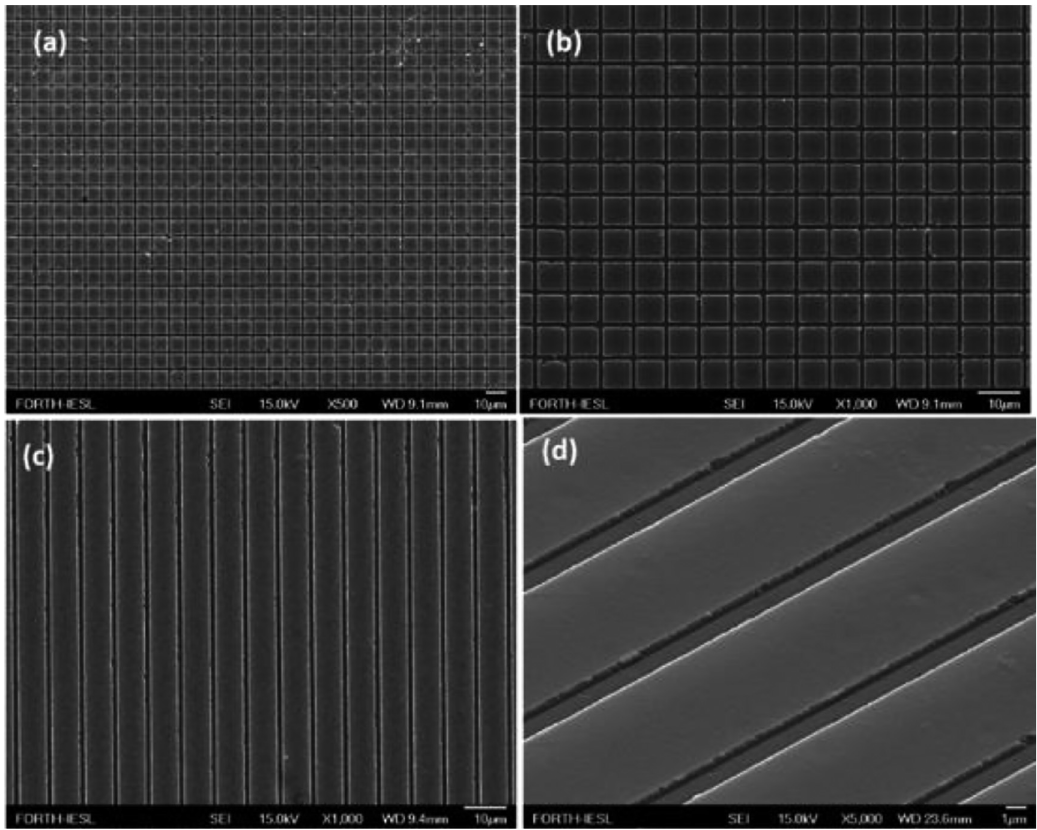
Figure3: RepresentativeSEMimagesfromthehybridphotoresistconsistingofMAPTMS : ZPO8 : 2molarratio(aandb)imagesofapatterned area consisting of squares (c and d) a patterned area consisting of